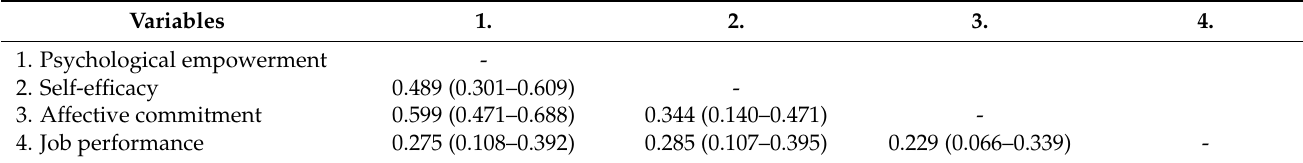
Table 4. Discriminant validity analysis